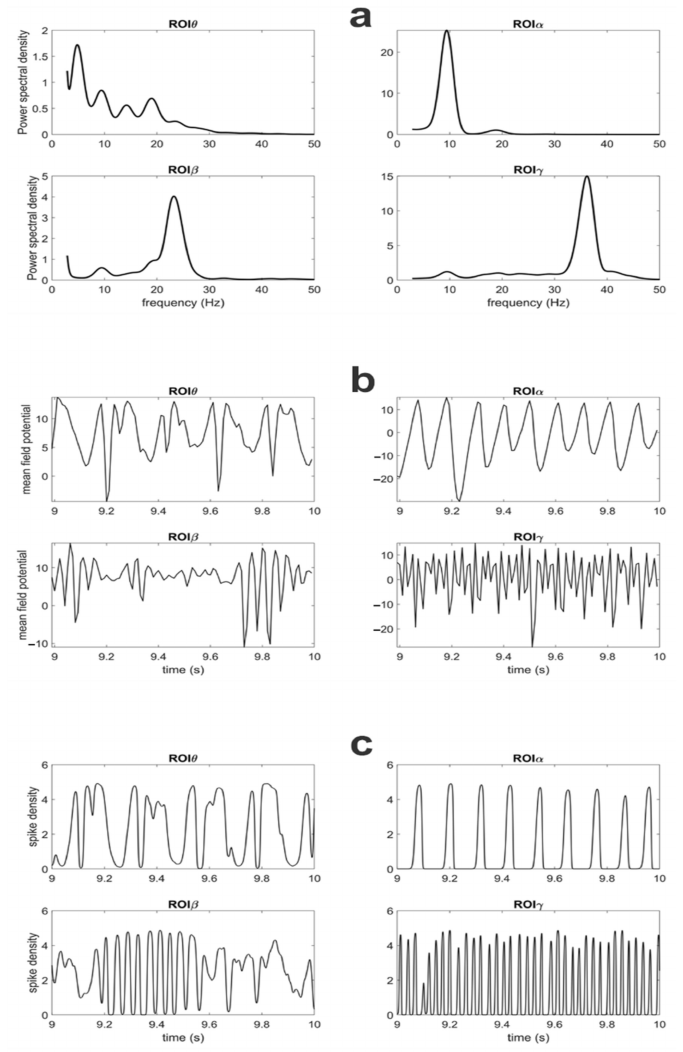
Figure 3. Power spectral densities of potential for the pyramidal population in the four different ROIs ( a ) simulated with the connectivity as in Figure 2A and all inputs as great as 400. Power spectral densities (PSDs) have been obtained by computing the Welch periodogram on membrane potentials of pyramidal neurons. Parameters for each ROI and noise levels are shown in Table S1 of Supplementary Materials part 1. ( b , c ) represent the temporal pattern of membrane potential of pyramidal neurons and their spike densities, respectively, during the last second of the